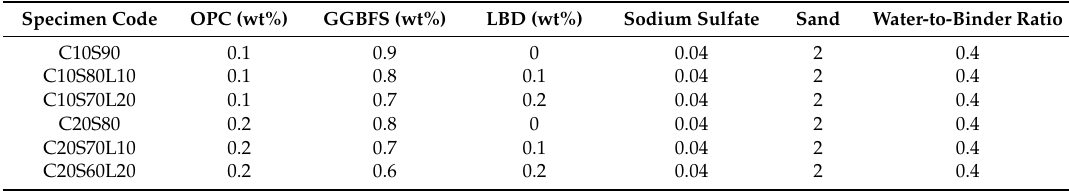
Figure 2. XRD patterns of LBD. Table 2. Mix composition of the